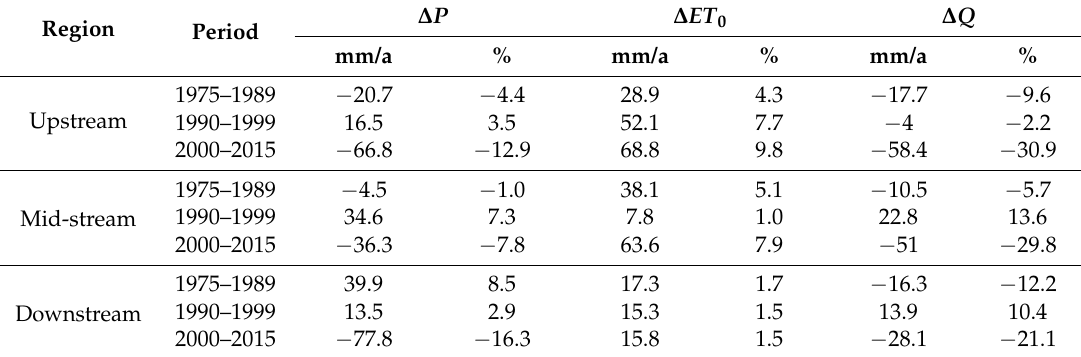
Changes of precipitation, potential evapotranspiration, and observed runoff in the Nenjiang River